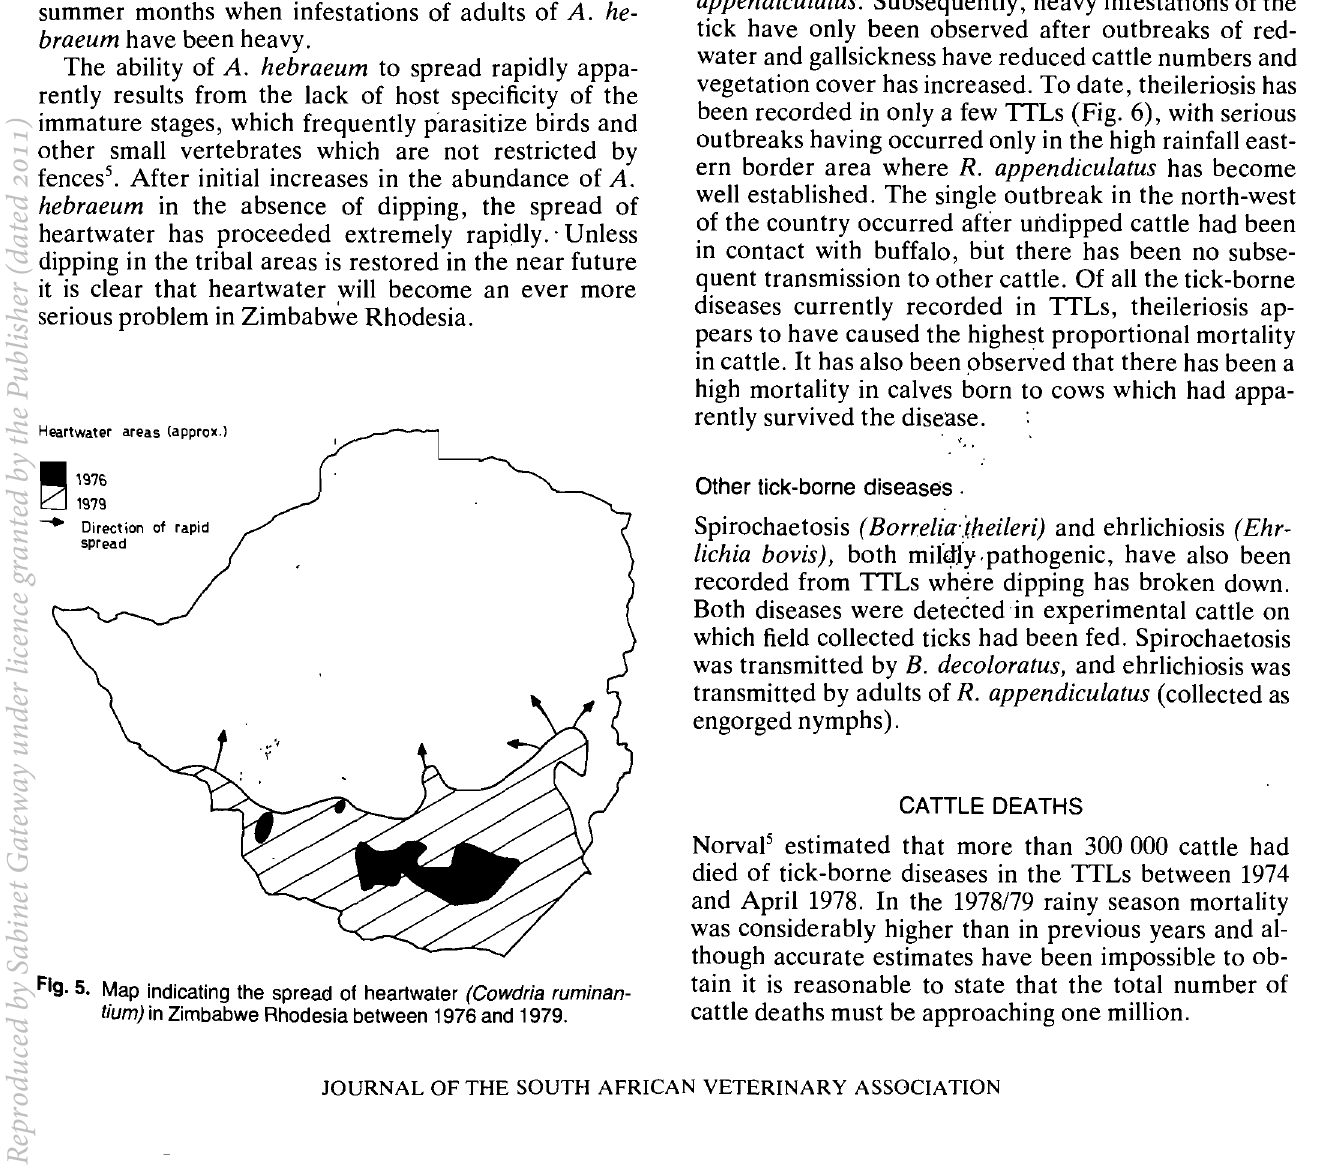
Fig. 6. Map of Zimbabwe Rhodesia indicating areas in which Rho desian theileriosis (Theileria lawrencei) has been recorded subsequent to the cessation of